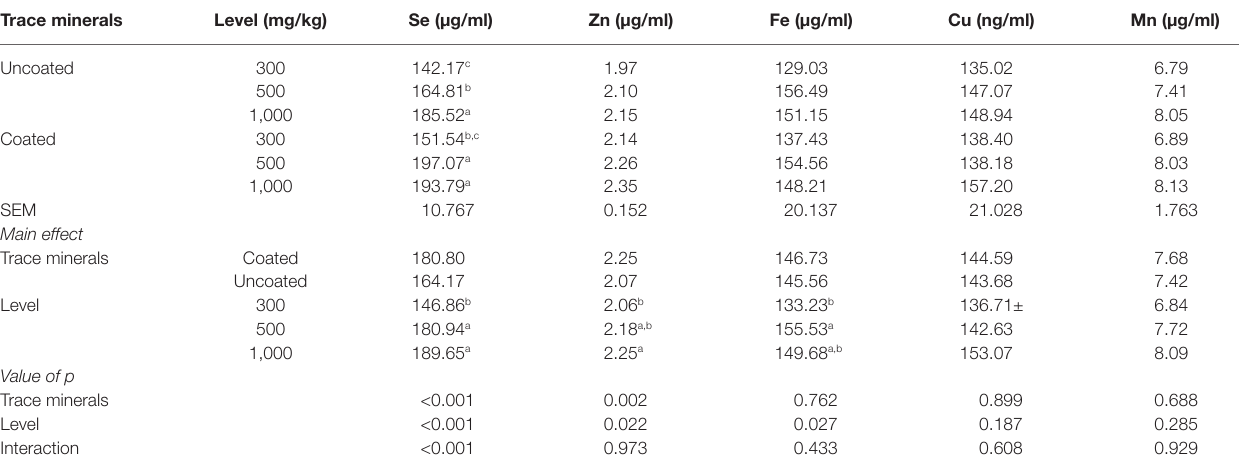
TABLE 7 | Effects of trace mineral type (coated or uncoated) and supplementation level (300, 500, or 1,000 mg/kg) of trace minerals on serum ion metals contents in ducks.